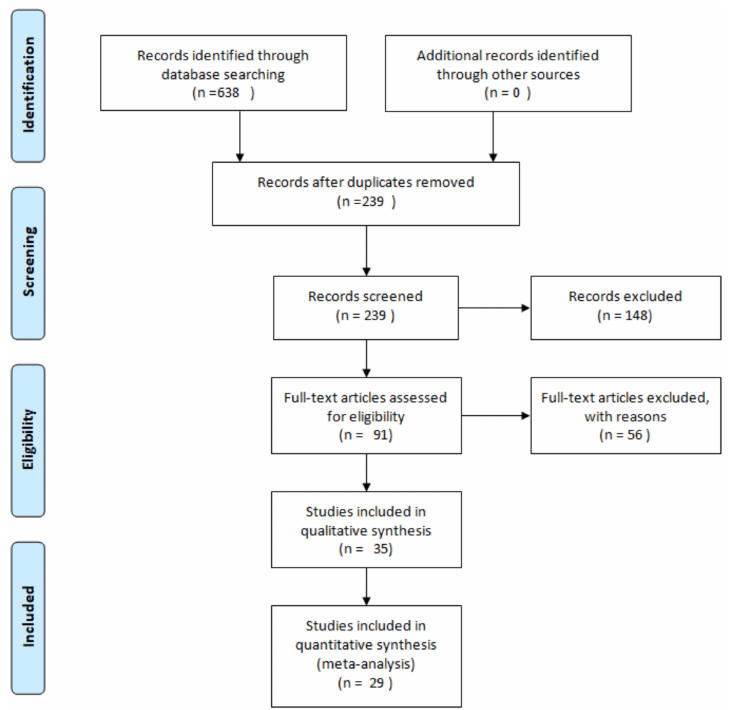
Figure 1. Prisma flow diagram of the methodology for selecting the review